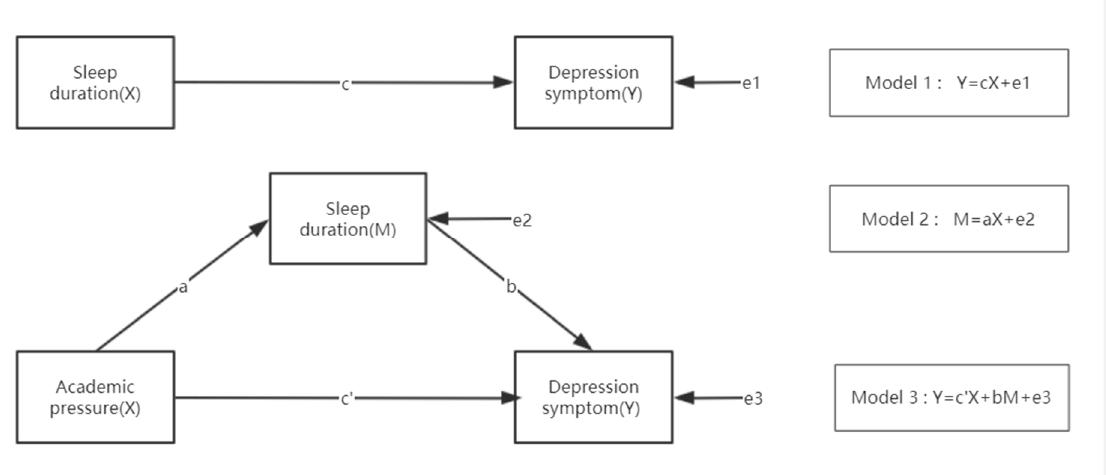
Figure 1. The framework of the potential mediating effect of sleep duration on the association between academic pressure and depressive symptoms.